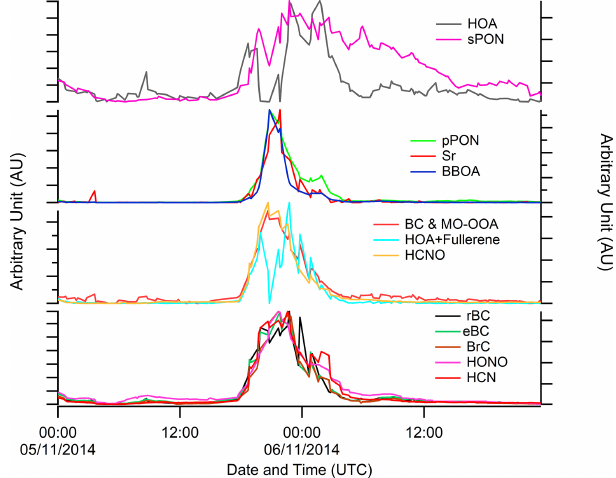
Figure 5. Time series of the pollutants, grouped according to the hierarchical cluster analysis in Fig.